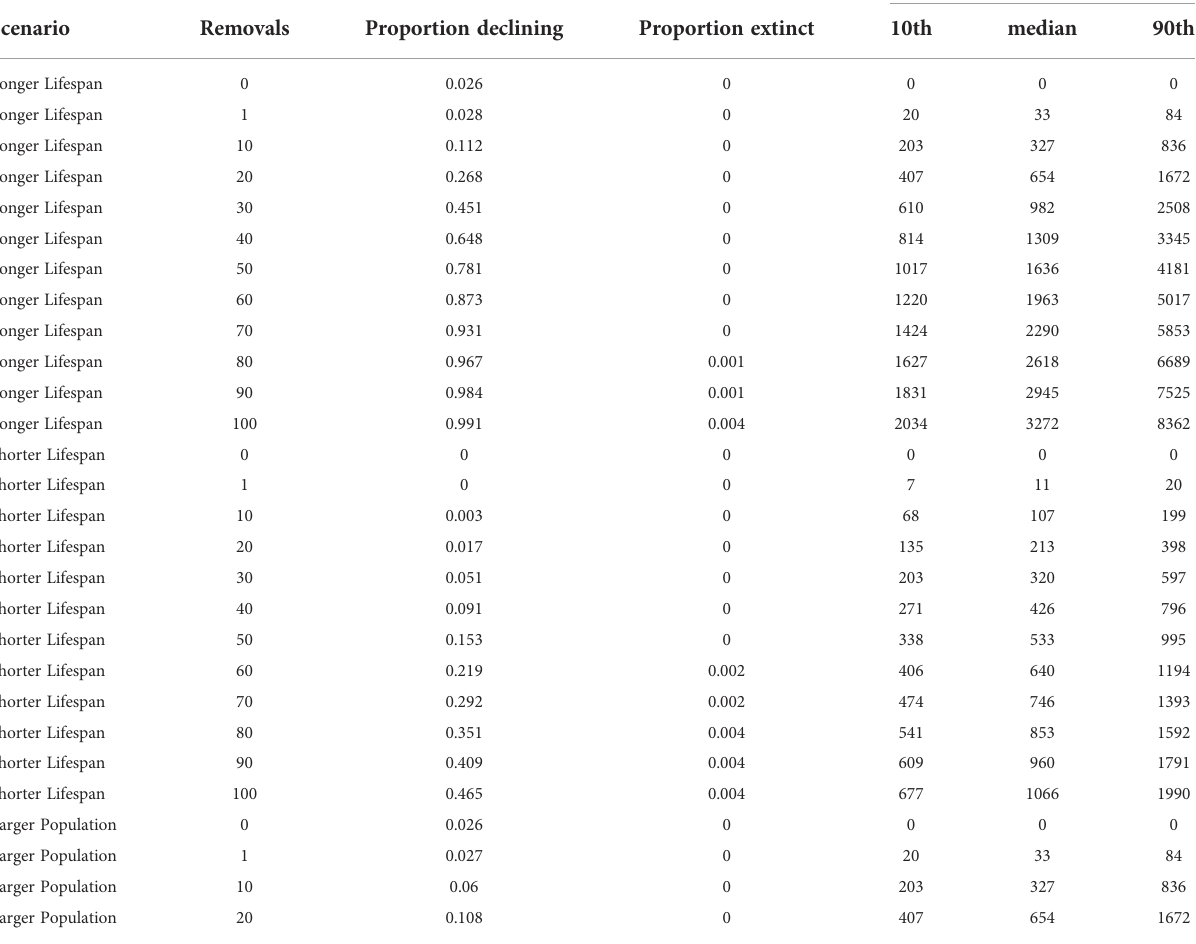
TABLE 2 The proportion of simulations that were declining and the proportion that reached the extinction threshold in the future projections (2018-2070; one generation). The median (and 80th percentile) number of females that would be required to balance removals so that abundance remained constant (Ncrit) is also shown for each life history scenario and removal